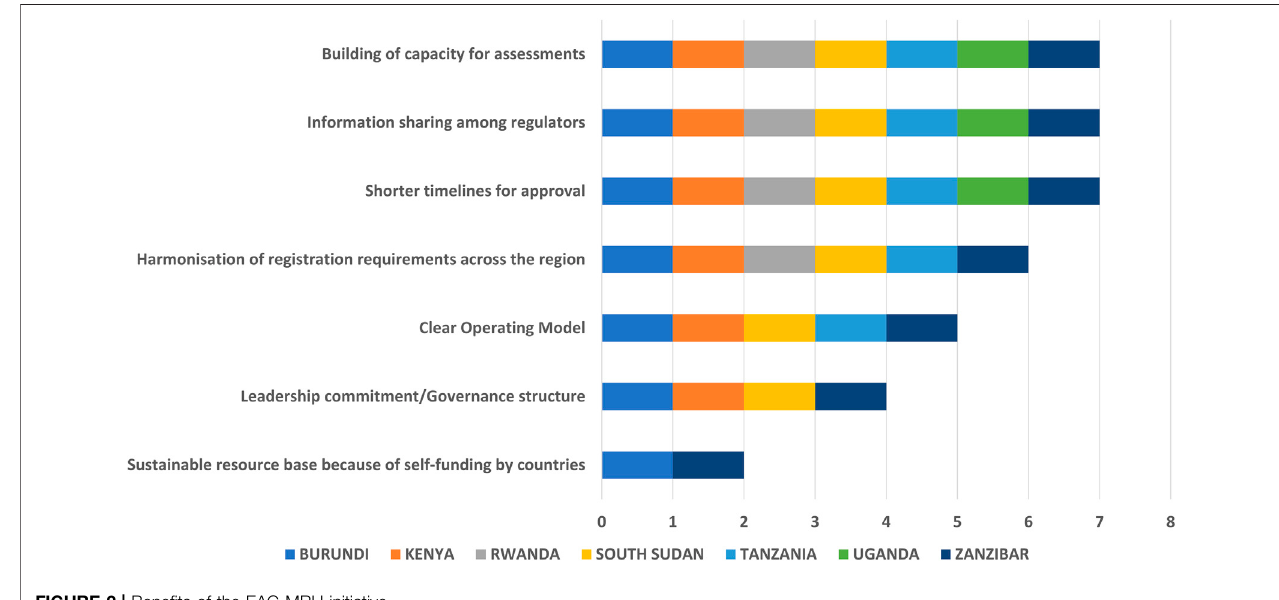
FIGURE 2 | Bene fi ts of the EAC-MRH initiative.